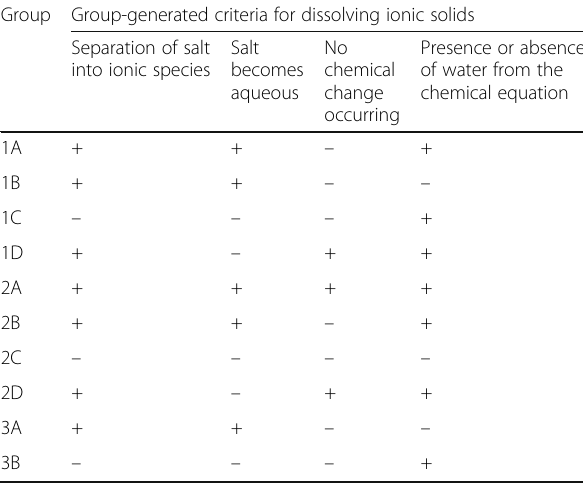
Table 4 Comparison of group uses of student-generated criteria for the dissolution of ionic solids in water ( ‘ + ’ means group used indicated criterion whereas ‘ - ’ they did not ) Group Group-generated criteria for dissolving ionic